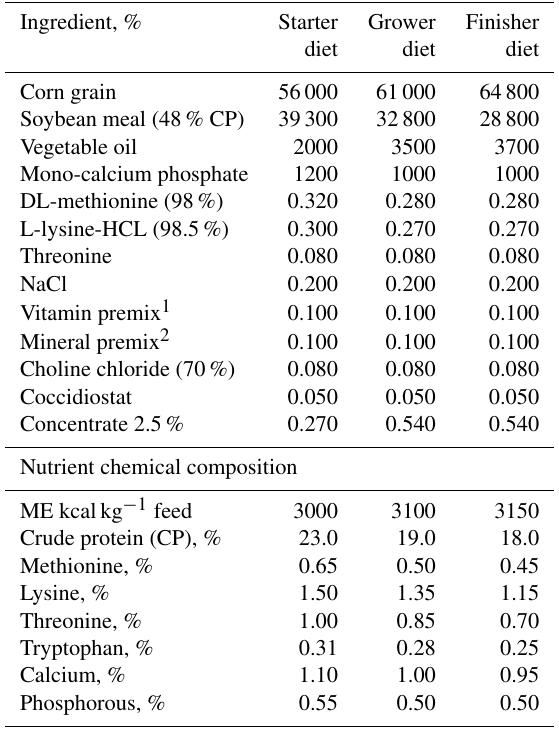
Table 1. Ingredients and composition of